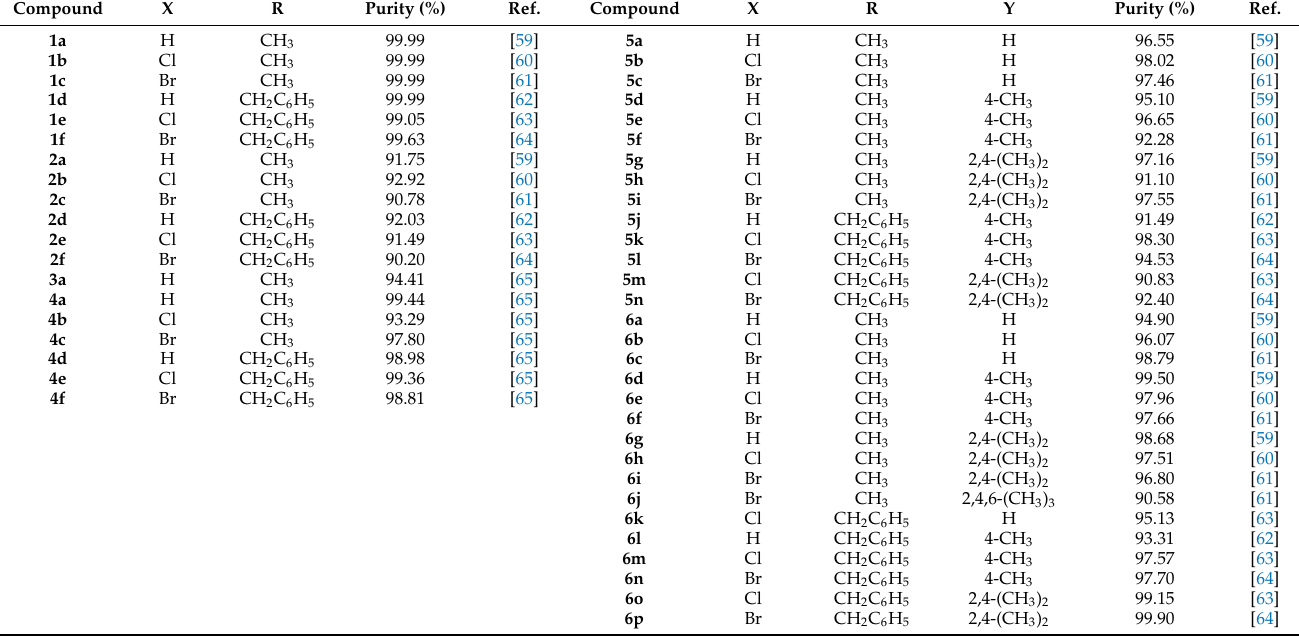
Table 1. The chemical structures and purities (%) of the tested compounds.